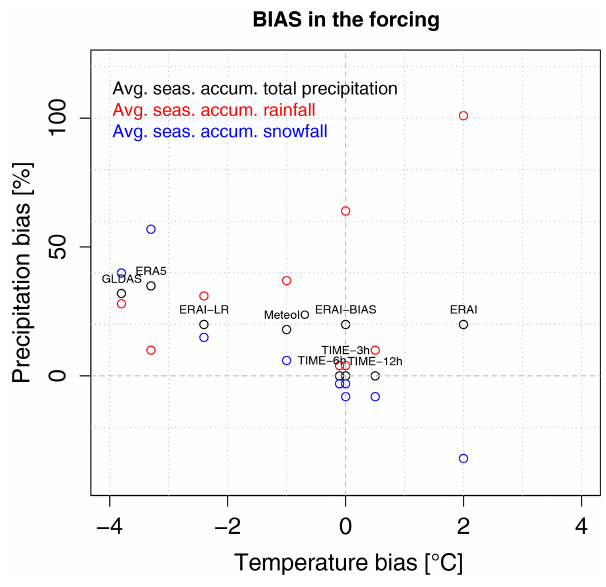
Figure 3. Temperature, total precipitation, rainfall and snowfall av- erage seasonal biases in the forcings employed in each experiment with respect to the Torgnon station